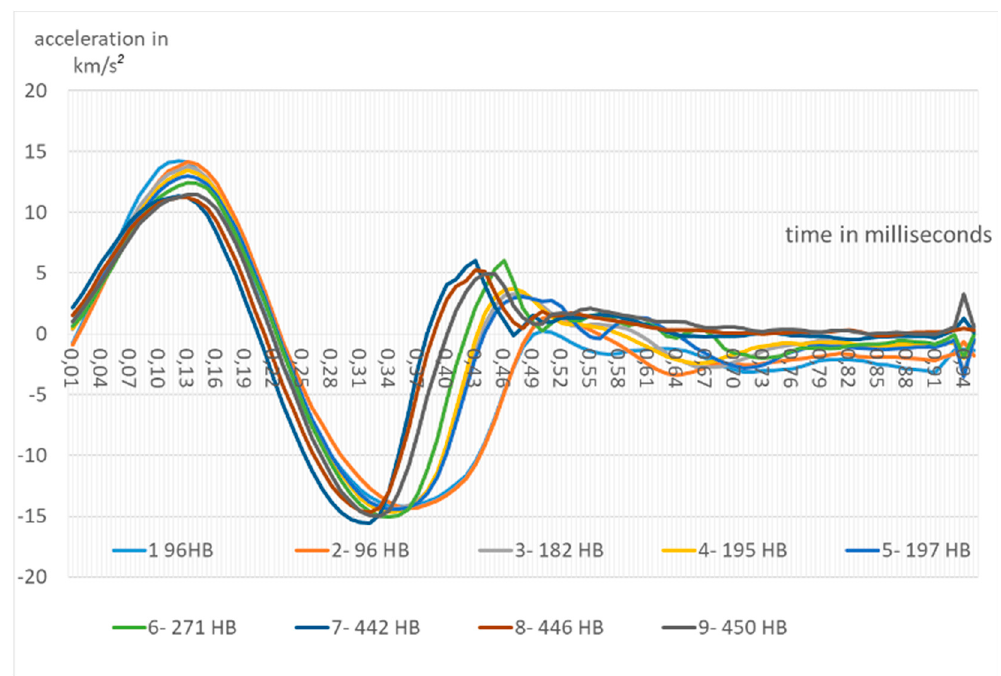
Figure 6. Experimental dependences indenter acceleration during of the shock